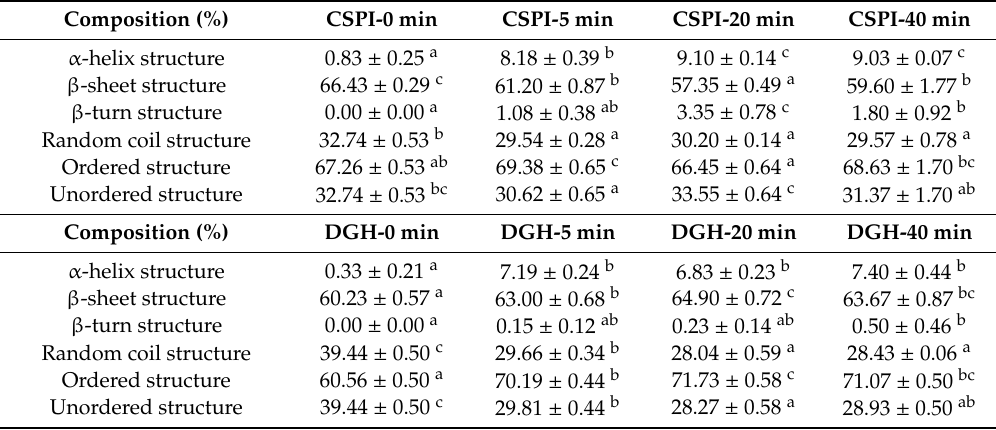
Table 3. E ff ect of high-intensity ultrasound treatment (20 kHz at 400 W for 0, 5, 20, 40 min) on the secondary structure of CSPI and